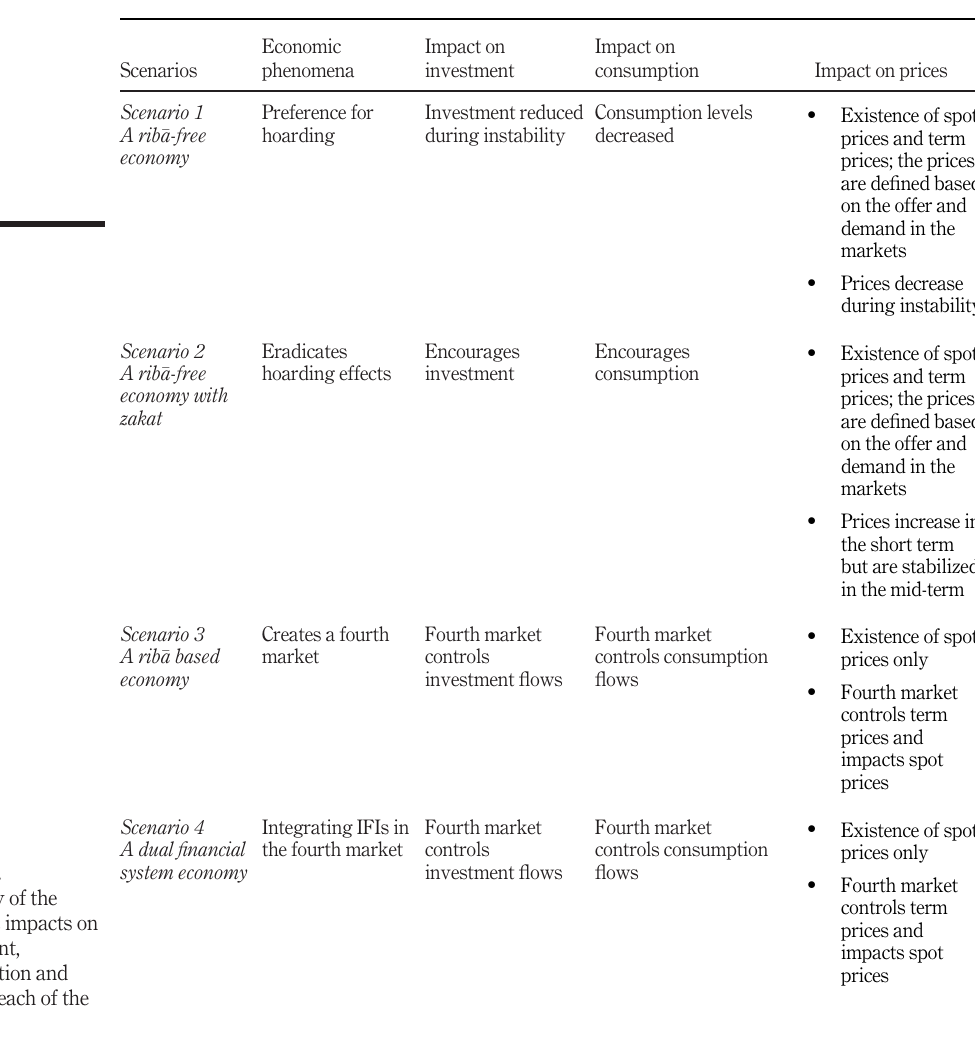
Table 1. Summary of the economic impacts on investment, consumption and prices in each of the